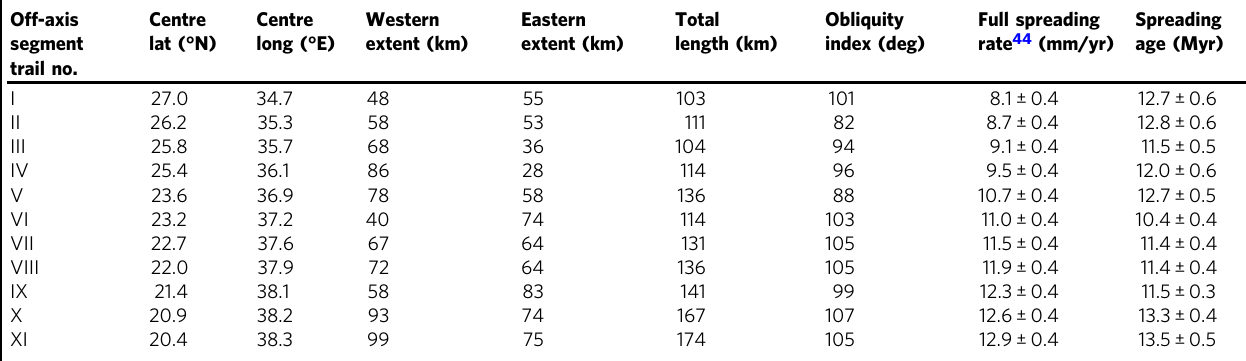
Table 1 Spatial characteristics of identi fi ed off-axis segmentation trails along the Red Sea Rift. Off-axis segment trail